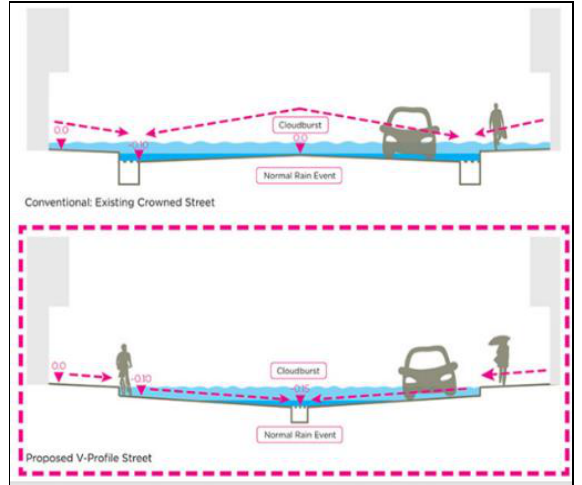
Figure 1 . Conceptual road cross section Classical (up), cloudburst